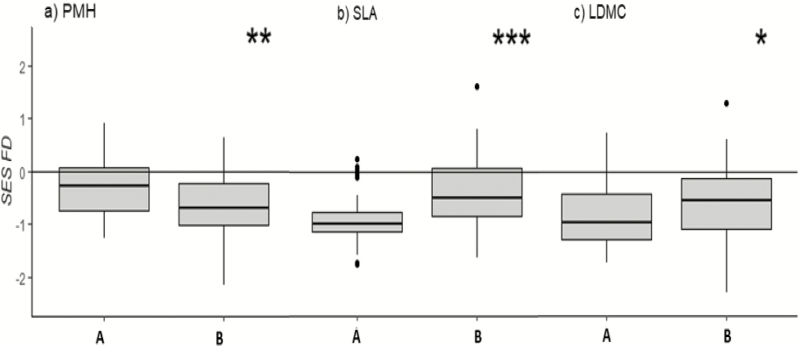
Box plots comparing the standardized effect size (SES) FDt values of subalpine Sesleria juncifolia (A on the horizontal axis) and alpine Silene acaulis (B on the horizontal axis) communities. The differences in the FDt are significant for (A) plant maximum height (PMH), log cm; (B) specific leaf area (SLA), log t mm2 mg−1; and (C) leaf dry matter content (LDMC), log mg g−1. Statistical significance according to the Mann–Whitney U-test is represented by asterisks (non significant P > 0.05; *P < 0.05; **P < 0.01; ***P < 0.001).